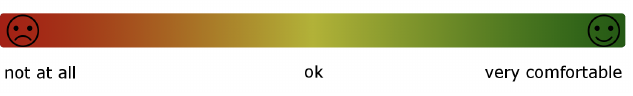
Figure 2. Example of a question presented to the participants